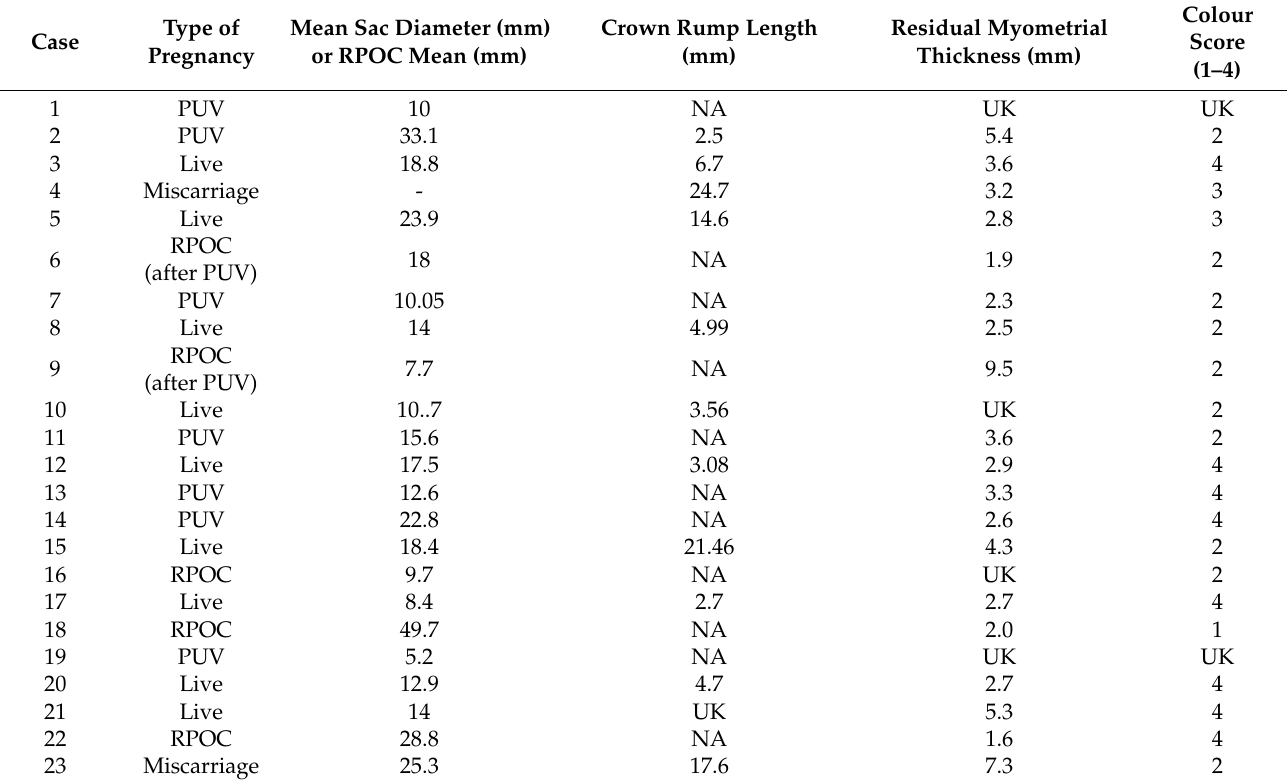
Table 1. Ultrasound characteristics of cases at time of specialist ultrasound